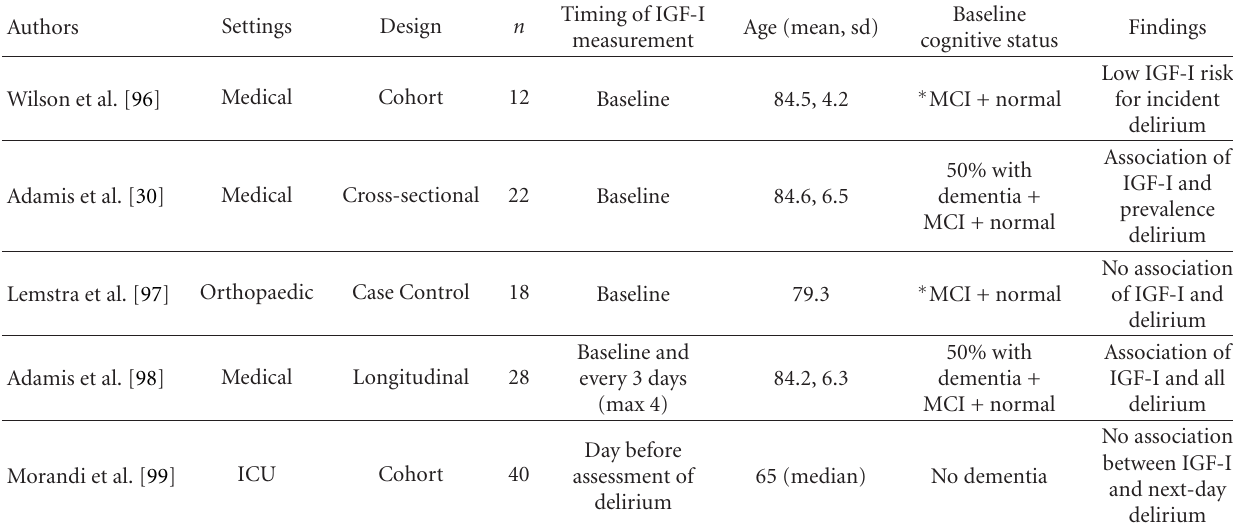
Table 1: Studies of IGF-I in